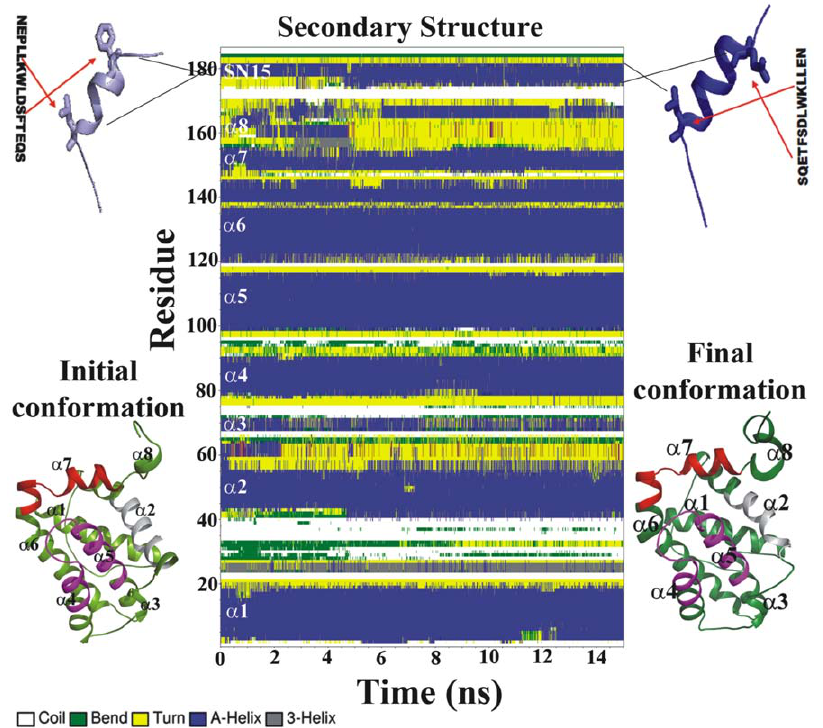
Figure 3. Stability of secondary structural features of Bcl-X L /SN15 complex. Secondary structural characteristics were calculated using DSSP for total simulation to understand the stability and changes for the Bcl-X L /SN15 complex. The initial (7 residues) and final (9 residues) helix length of the SN15 are represented with starting and ending residues of helix and highlighted by arrows. Initial and final frames of the protein represented as cartoon model and